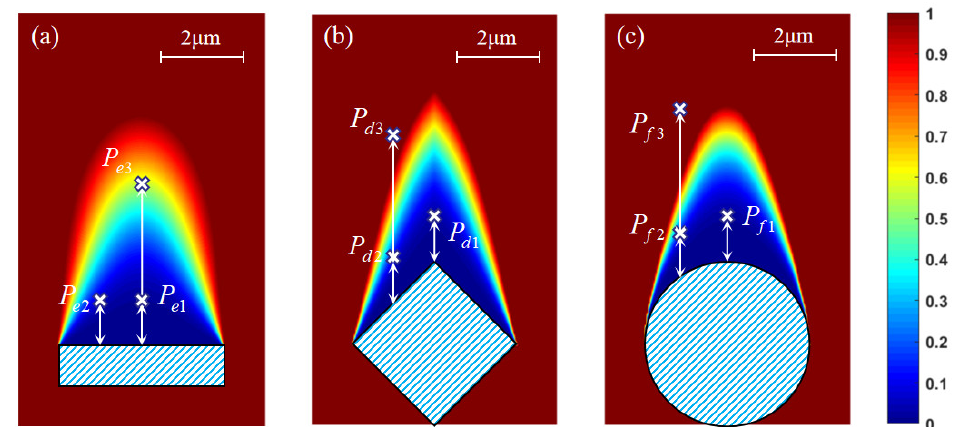
Figure 8. The δ distribution behind ( a ) the rectangular shading structure; ( b ) the diamond shading structure ( c ) the circular shading structure calculated from the PGFM. The precursor gas flows from the bottom to the top.